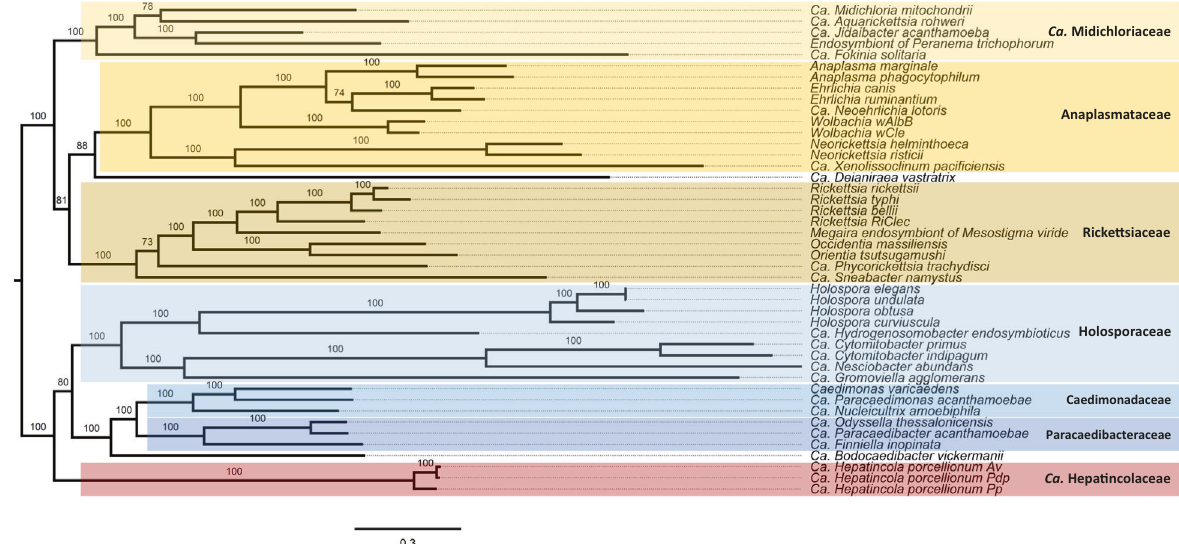
Fig. 4 Phylogenetic placement of Hepatincola within the Holosporales . Maximum likelihood tree based on the concatenated amino acid sequence alignment of 62 single-copy orthologous genes from 44 representatives of the orders Holosporales (blue) and Rickettsiales (yellow). The three Hepatincola strains are highlighted in red. Branch support is based on 1000 bootstrap